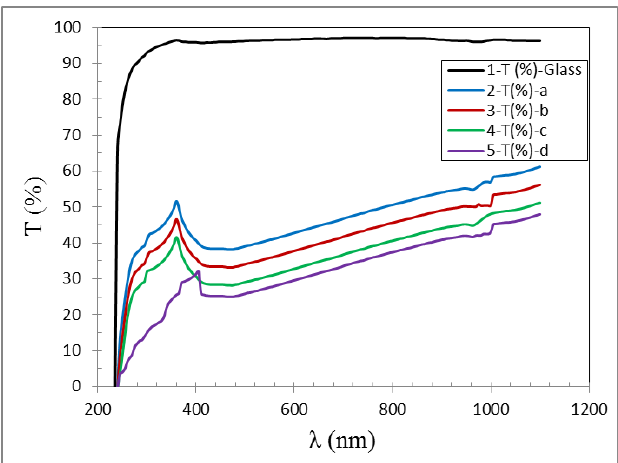
Fig.2: Variation of transmittance with wavelength of (1) glass pure (2) glass for different doping concentrations of graphene oxide thin films ((a) 2%, (b) 4%, (c) 6% and (d) 8%